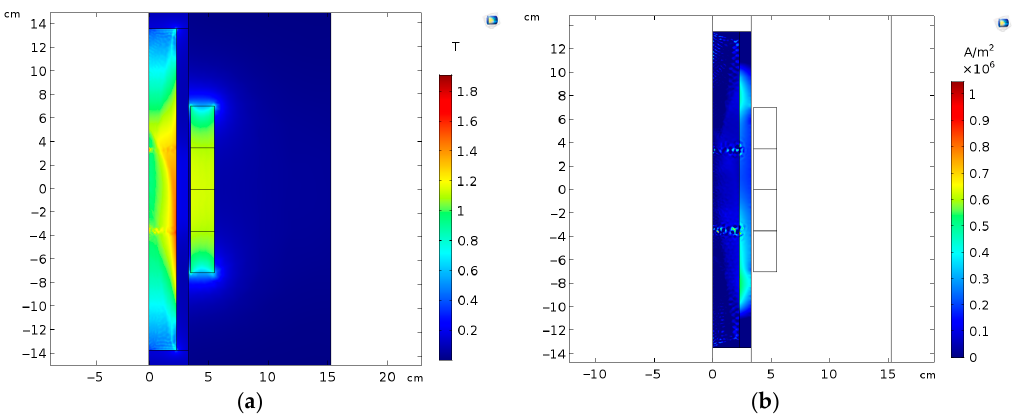
Figure 7. For Model IV: ( a ) Magnetic flux density, ( b ) induced current density, at v = 1.0 m/s.